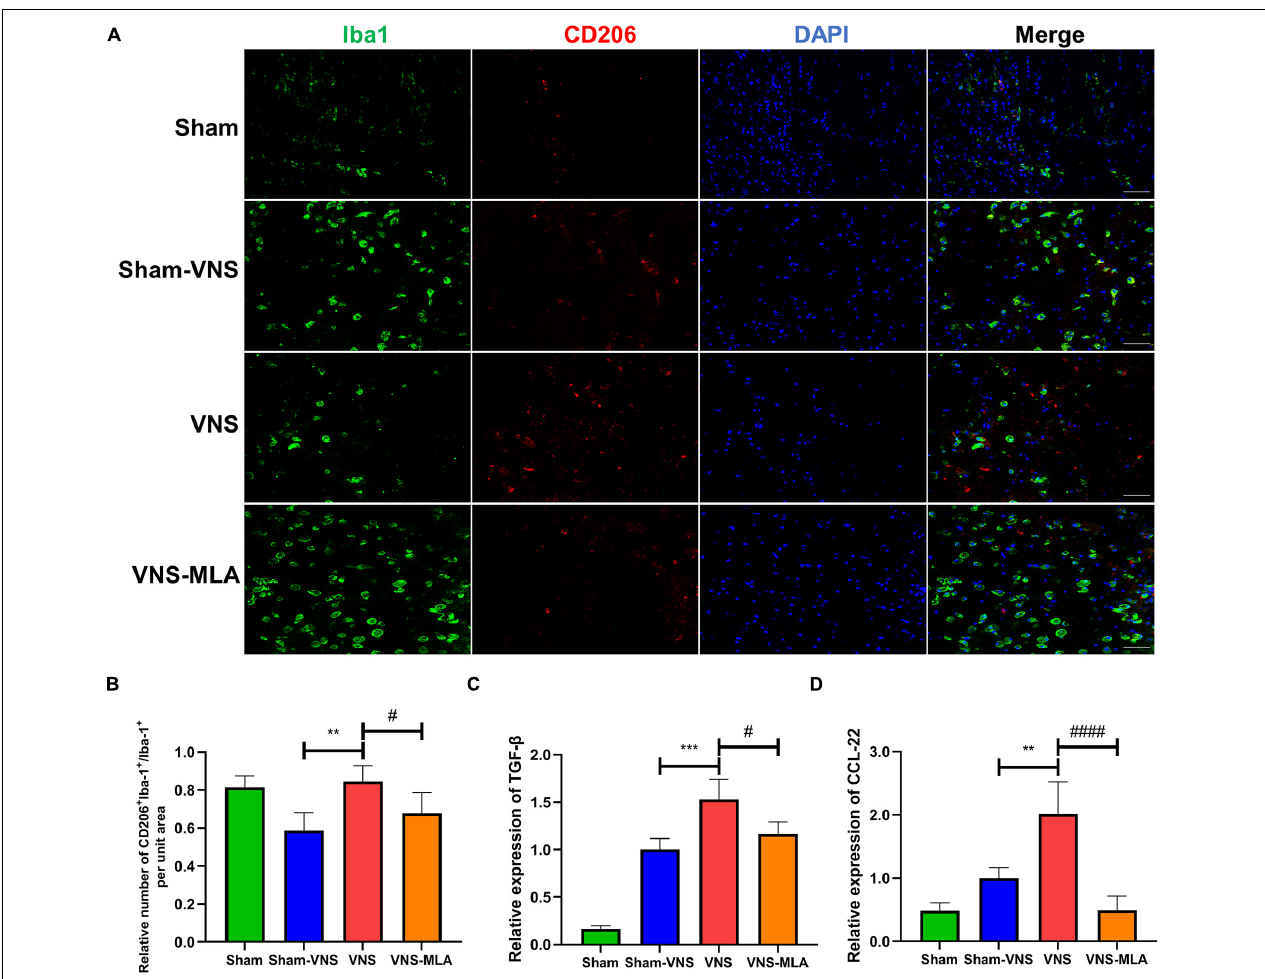
FIGURE 6 | Vagus nerve stimulation (VNS) significantly increases CD206 expression in microglia. (A) Representative images showing Iba-1+/CD206+IF staining after spinal cord injury (SCI), n = 5 per group, scale bar = 50 µ m. (B) Quantitative analysis of the results in panel a, n = 5 per group. (C,D) Relative mRNA expression levels of Arg-1 and IL-4 in all groups, as detected by qRT-PCR, n = 4 per group). ** P < 0.01, *** P < 0.001 VNS vs. Sham-VNS group. # P < 0.05, #### P < 0.0001 VNS vs. VNS-MLA